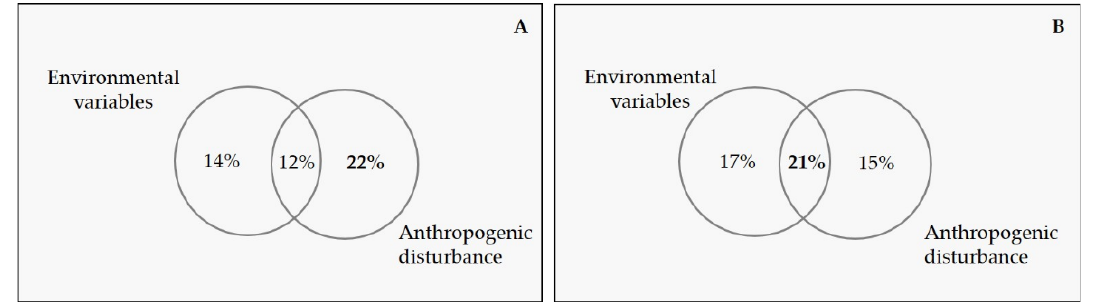
Figure 3. Veen diagrams showing the partition of the variation in the occurrence (presence/absence) ( A ) and abundance (density, ind∙100 m − 2 ) ( B ) of Alburnus alburnus explained by environmental and anthropogenic disturbance variables.